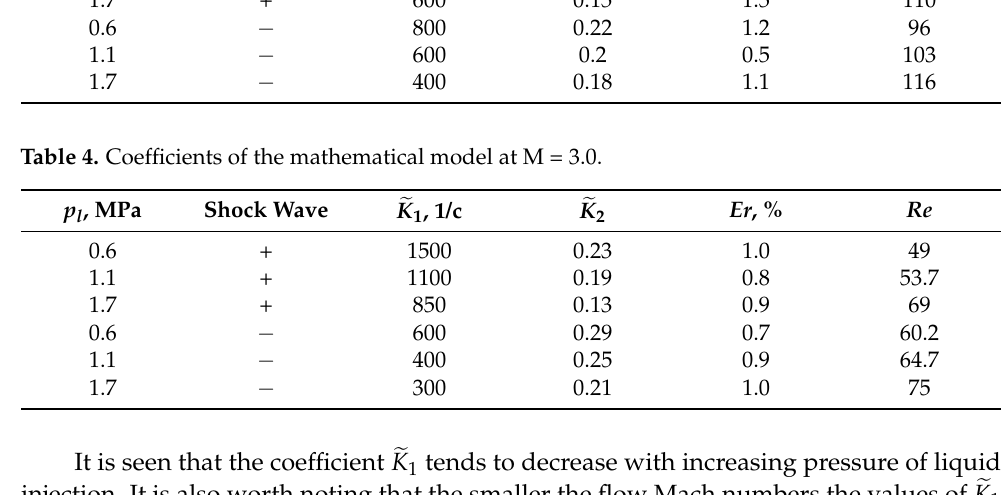
Table 4. Coefficients of the mathematical model at M = 3.0.